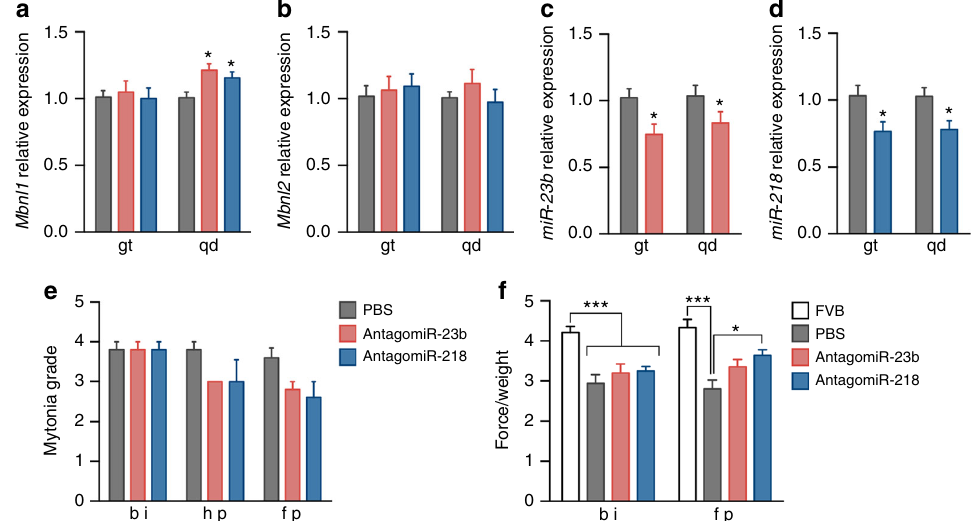
Fig. 7 Muscle function is improved in HSA LR mice 6 weeks after injection of antagomiRs. a , b qRT-PCR quanti fi cation of Mbnl1 and Mbnl2 transcript levels in gt and qd muscles of untreated mice (PBS, gray bars) or treated with antagomiR-23b (pink bars) or antagomiR-218 (blue bars). c , d Real-time PCR quanti fi cation of miR-23b and miR-218 . e Electromyographic myotonia grade in antagomiR (pink and blue bars) or PBS-treated (gray bars) HSA LR mice before (bi), in the halfway-point (hp) and 6 weeks after injection ( fi nal point, fp). f Forelimb grip strength of mice treated with antagomiRs measured before injection (bi) and 6 weeks after injection (fp). The grip force was normalized with the body weight of each mouse. The data were analyzed by unpaired Student ’ s t test compared to HSA LR mice treated with the vehicle PBS. Data are mean ± SEM. * p < 0.05, *** p < 0.001; FVB ( n = 5), HSA LR PBS ( n = 6), HSA LR antagomiR-23b ( n = 5) and HSA LR antagomiR-218 ( n =